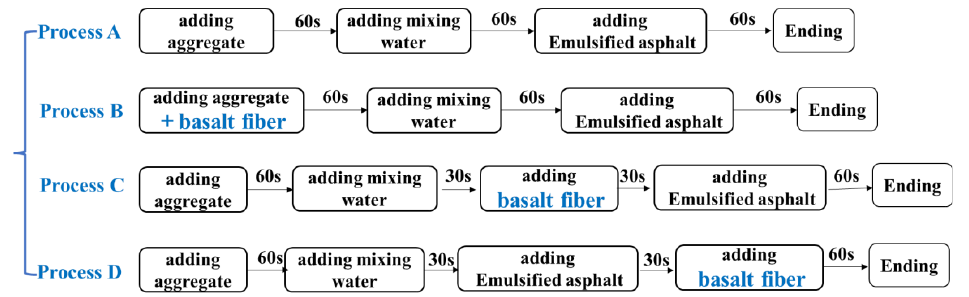
Figure 4. Four kinds of fiber mixing processes.